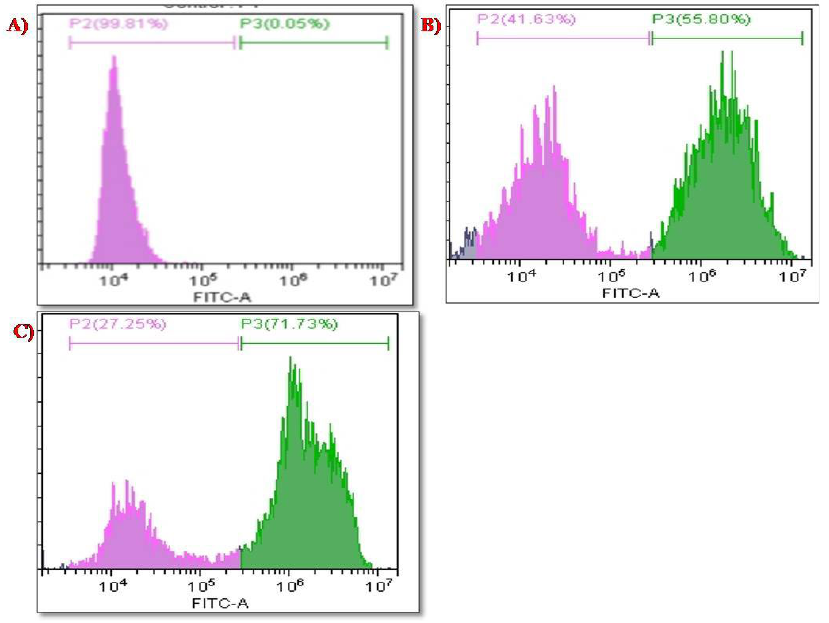
Figure 12. ROS analysis for ( A ) control cell population, ( B ) biosynthesized SeNPs, ( C ) PTX-chit- SeNPs-treated population.